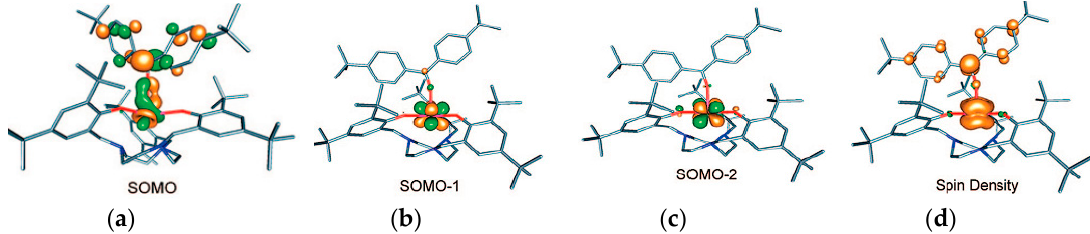
Figure 26. Formation of U(IV) benzophenone ketyl radical complex 2 through a one-electron reduction of 4,4 ′ -Di-tert-butylbenzophenone by U(III) precursor complex [((t-BuArO) 3 tacn)U III ] ( 1 ) followed by H abstraction to form a U(IV) diphenyl methoxide complex 3 [164].